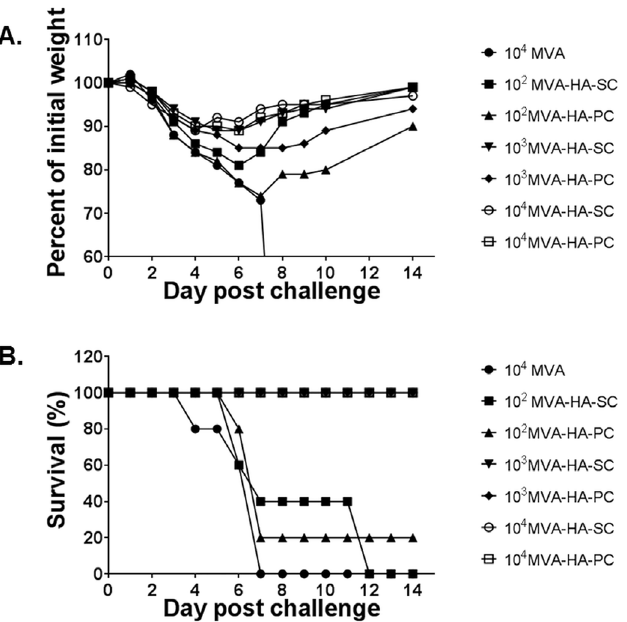
Fig 4. Evaluation of vaccination routes by low dose treatment with MVA-HA. Mice in groups of 5 were vaccinated with MVA or MVA-HA at the doses indicated in the legend. Booster vaccinations were administered after 3 weeks, and mice were challenged with 10 6 pfu of influenza rgA/Viet Nam/1203/2004 (H5N1), three weeks after the second vaccination. Mice were weighed for 14 days post challenge. Weight loss as a measure of disease severity is shown in A , and the proportion of surviving animals in the different treatment groups are represented in B . doi:10.1371/journal.pone.0149364.g004 Finally, in two independent experiments, mice in groups of five in each experiment were vaccinated with low doses of MVA-HA that were administered once, and were challenged three weeks after vaccination. Groups of mice were inoculated at doses of 10 2 , 10 3 , or 10 4 pfu of MVA-HA subcutaneously or percutaneously. Control groups received 10 4 pfu of MVA subcu- taneously. A summary of the number of surviving mice is presented in Table 4. None of the mice vaccinated with MVA survived. Among mice in the MVA-HA subcutaneous vaccination cohort, 3/10, 5/10, and 8/10 survived in the 10 2 pfu, 10 3 pfu, and 10 4 pfu vaccination groups, respectively. Similarly, among mice in the percutaneous vaccination cohort, 5/10, 6/10, and 8/ 10 survived viral challenge. The mean weight loss among mice in these experiments are shown in Fig 5. Statistical comparisons of the number of surviving mice show that differences in sur- vival between mice that were vaccinated with 10 4 pfu of MVA-HA (irrespective of vaccination Table 4. Protection of mice following single dose percutaneous or subcutaneous vaccination with MVA-HA. Group A a,b,c B d C D E F G Treatment 10 4 MVA Total No. of Mice No. of